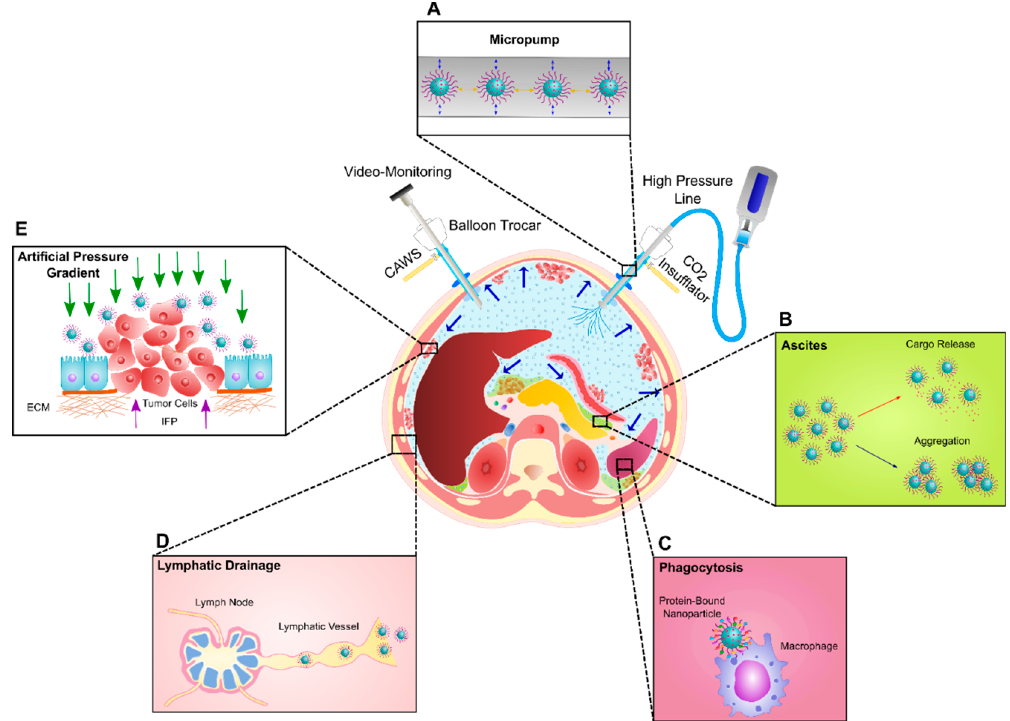
Figure 2. Schematic illustration of challenges to the intraperitoneal aerosolization of nanotherapeutics using Pressurized Intraperitoneal Aerosol Chemotherapy (PIPAC). ( A ) Colloidal stability of NPs against the pressures generated during the nebulization process. ( B ) Colloidal stability of NPs in the presence of biofluids (e.g., Ascites). ( C ) Adsorption of highly abundant proteins present in the peritoneal cavity on the surface of NPs and subsequent phagocytosis by resident macrophages in filtering organs (e.g., spleen and liver). ( D ) Lymphatic drainage of NPs. ( E ) Penetration of NPs into the peritoneal nodules through the creation of a high artificial pressure gradient counteracting the elevated interstitial fluid pressure (IFP) in tumors.